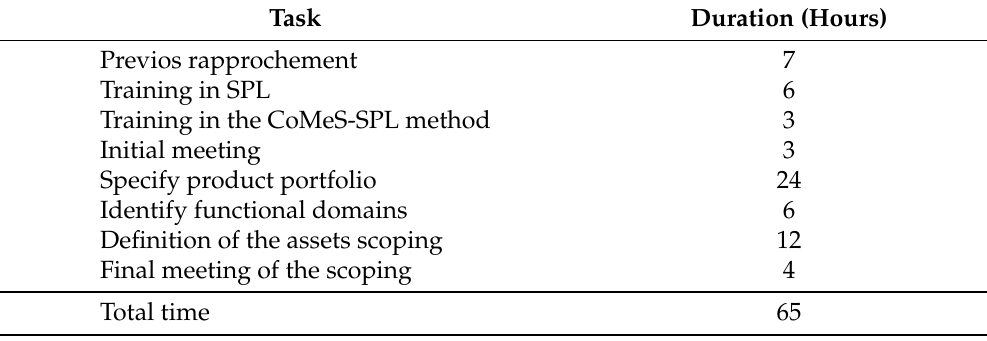
Table 6. Execution schedule of the